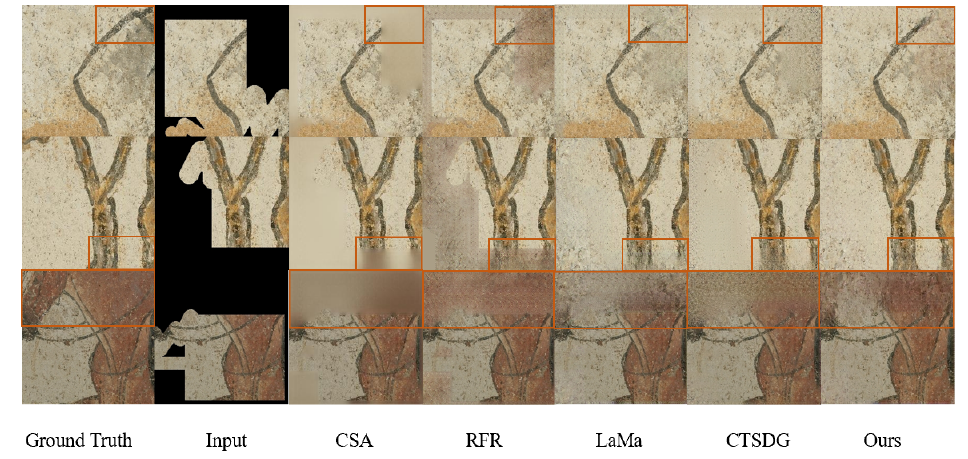
Figure 17. Comparison of inpainting results for each model of the large masks. Our model works best and looks more similar to the original after the